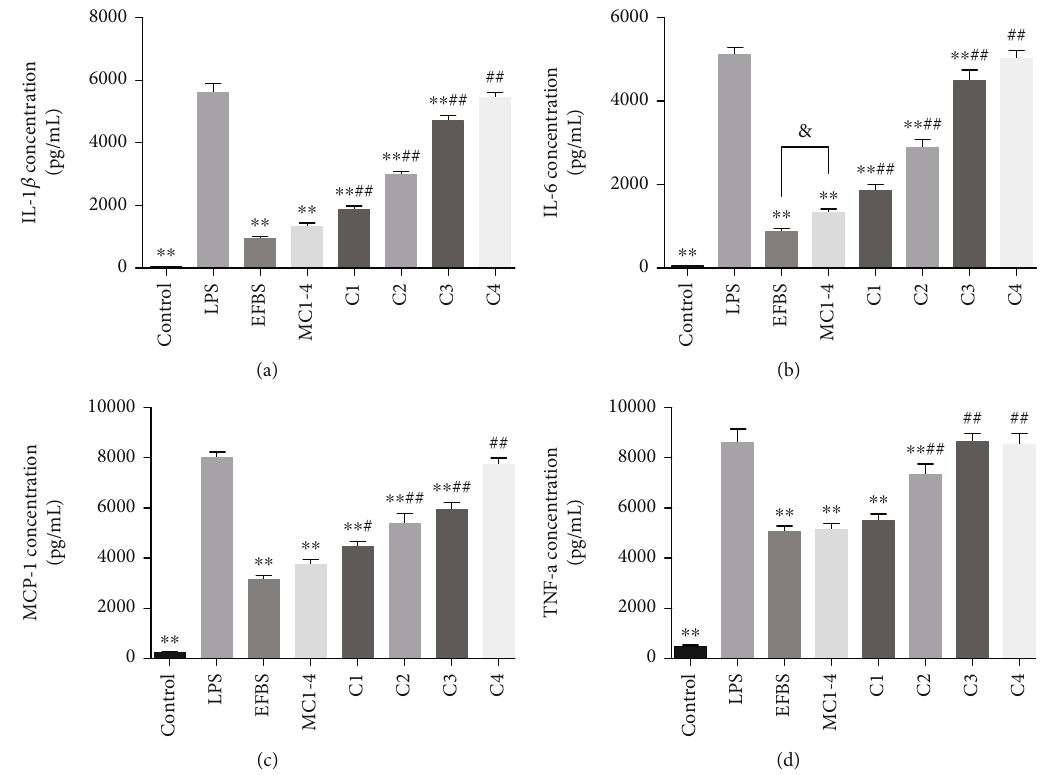
Figure 10: Proin fl ammatory cytokines inhibitory e ff ect of the four compounds. RAW264.7 cells were pretreated with EFBS (30 μ g/mL), MC1-4 (17.35 μ g/mL), C1(4.76 μ g/mL), C2 (9.75 μ g/mL), C3 (2.09 μ g/mL), or C4 (0.75 μ g/mL) for 1 h and followed by stimulation with LPS (200ng/mL) for 12 h. The culture supernatant was collected for IL-6, MCP-1, and TNF- α detection. The remaining cells were then treated by 1mM ATP for additional 15 min at 37 ° C; then, supernatants were collected for IL-1 β detection. All cytokines were quanti fi ed using the Cytometric Beads Array (CBA) method. Statistical analysis was performed using one-way ANOVA followed by the Tukey- Kramer posttest. ∗∗ P < 0 : 01 compared with the LPS treatment group. # P < 0 : 05 , ## P < 0 : 01 compared with the MC1-4 treatment group. & P < 0 : 05 .